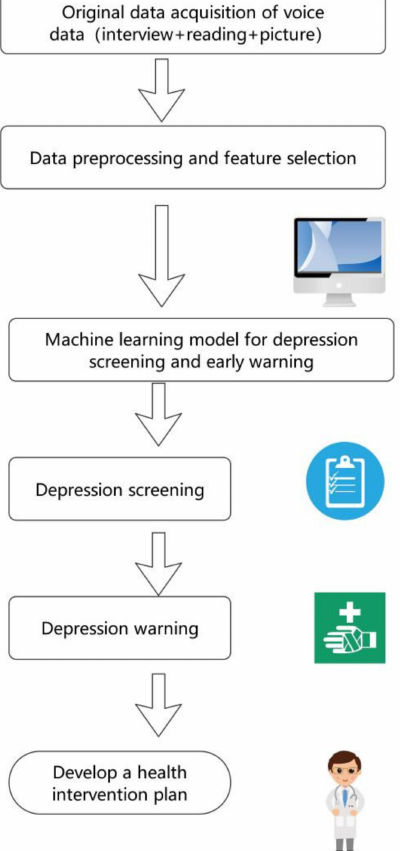
Figure 4. The depression screening and early warning model of this